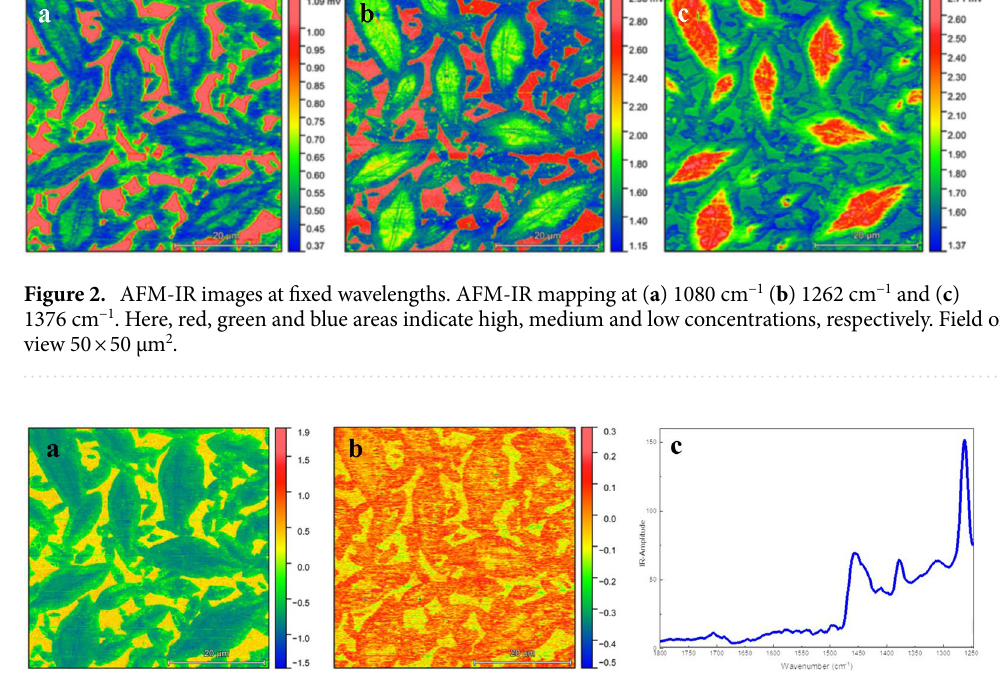
Figure 3. AFM-IR images at fixed wavelengths. AFM-IR mappings demonstrating ( a ) ratio I 1262 :I 1292 (Aryl C–O str; peak 1262 cm −1 vs baseline 1292 cm −1 ), ( b ) ratio I 1378 :I 1400 (aliphatic region; peak 1378 cm −1 vs baseline 1400 cm −1 ) and ( c ) representative AFM-IR